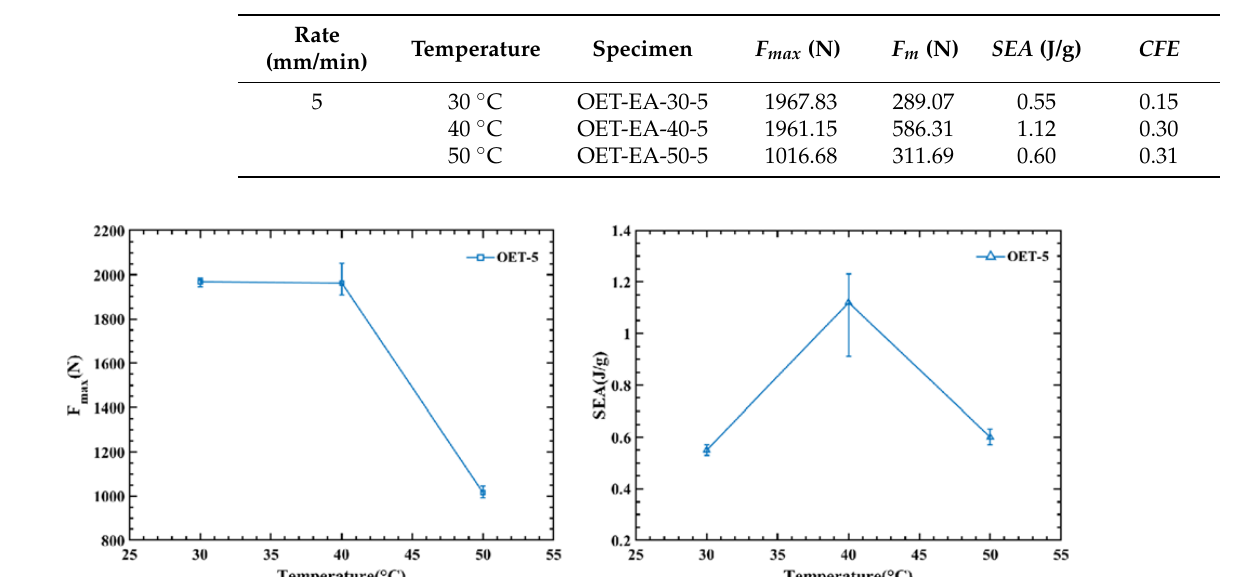
Table 7. Energy absorption index of OET at different temperatures when the compression rate at 5 mm/min.